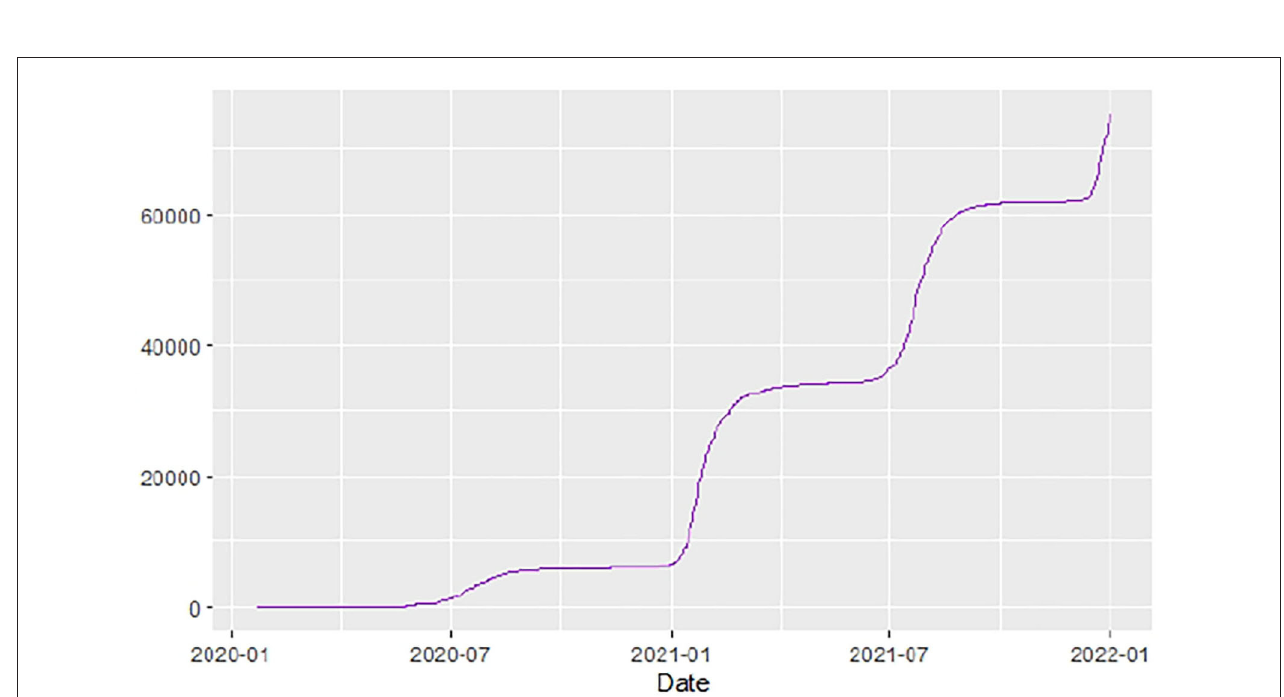
FIGURE 6 | Malawi